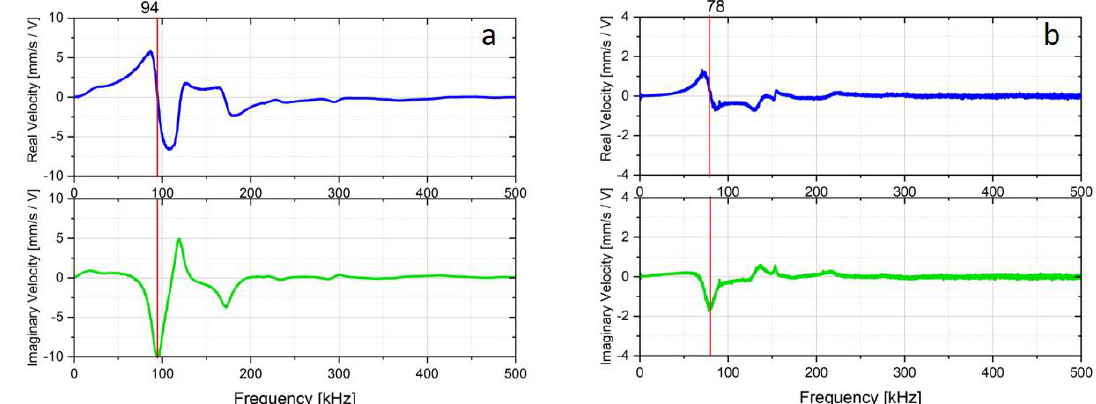
Figure 7. A comparison between the averaged LDV-Measurements of CMUT die before ( a ) and after ( b ) packaging indicating a shift in the first resonance frequency of ca. 16 kHz.